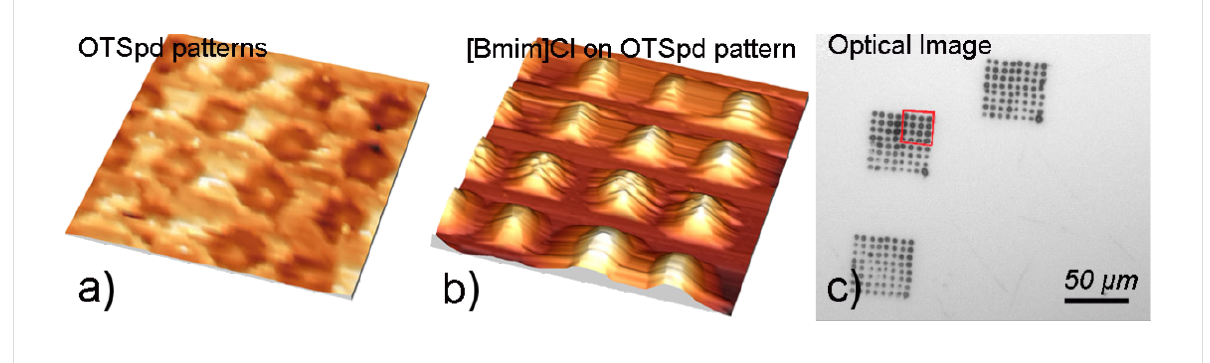
Figure 1: [Bmim]Cl assembles on the OTSpd pattern. a) OTSpd discs fabricated by scanning probe deep oxidation lithography on OTS film. Topog- raphy image. The center-to-center distance between two neighboring discs is ~7 μ m. b) The same area after [Bmim]Cl was coated on the sample. [Bmim]Cl selectively assembled on the lyophilic OTSpd discs. Topography image. c) Optical image of [Bmim]Cl assembled on the OTSpd patterns. The light background is the OTS film. The red box is the zone shown in a) and b). In this optical image, each IL drop assembled on an OTSpd disc appears as a dark